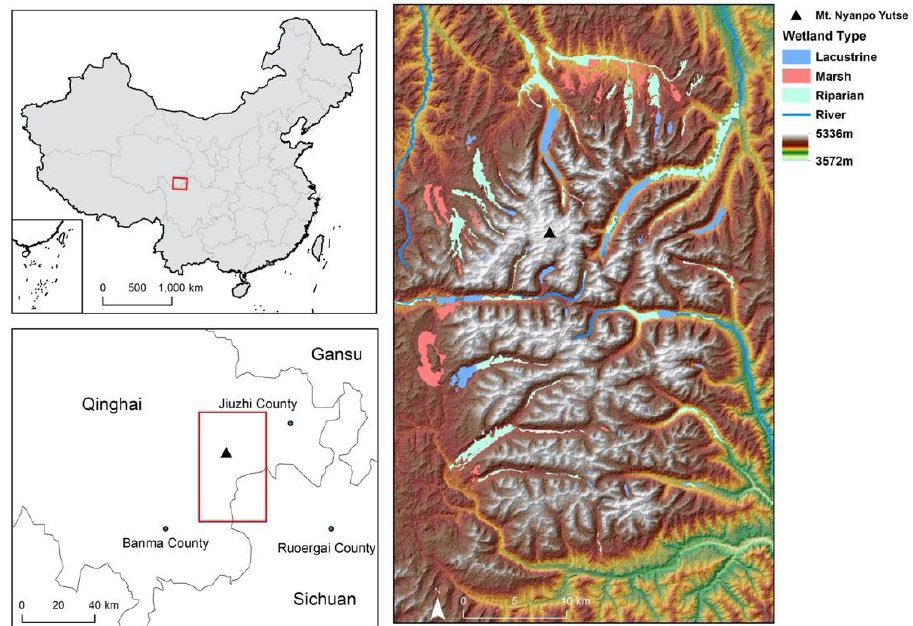
Figure 1. Maps of the study area. The map on the right shows the locations of three types of wetlands based on manual classification from Landsat remote sensing images. Lacustrine wetlands refer to the open water of cirque lakes and the surrounding semi-submerged ground. Marsh wetlands are wetlands distributed along the banks of rivers and cover the bottom of the glacial valleys.